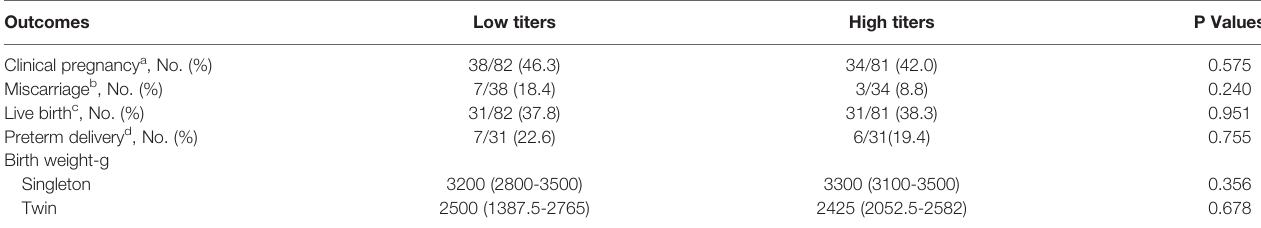
TABLE 8 | Subgroup analysis for pregnancy outcomes according to isolated TPOAb